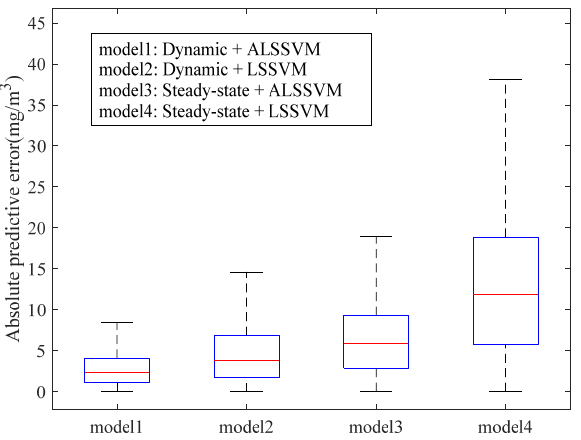
Figure 7. Boxplot of the prediction accuracy of the four modeling methods.